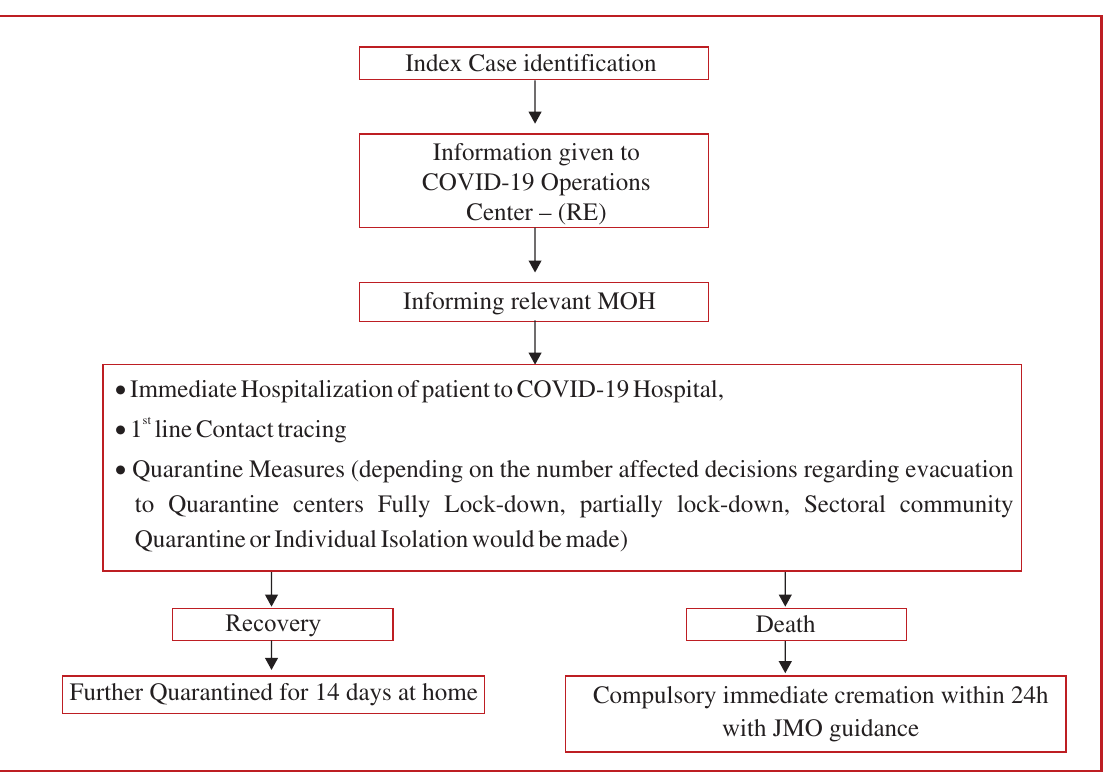
Figure 4: Flow chart of COVID-19 Management Strategy of the City of